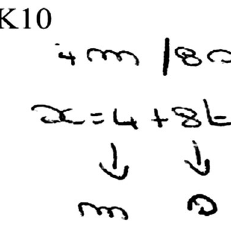
FIG. 12. Example of case 3 with question K10 in which equation x ¼ 4 þ 8 t was provided: a unit-based interval or point confusion in which the coefficients from the equation were each linked with a unit and then the appropriate ratio was taken to calculate the